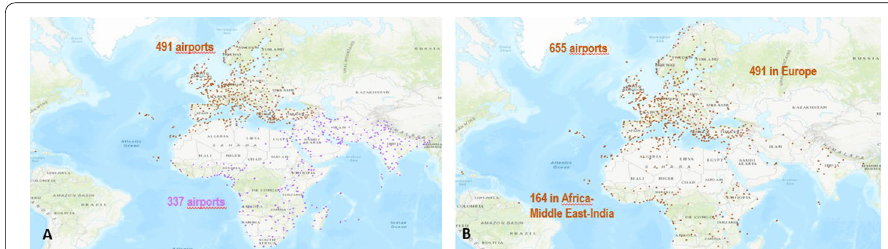
Fig. 3 Communities uncovered by Louvain are grouped in a single community by LPA. a Louvain reveals two communities in Europe (airports in brown) and Africa-Middle East-Southern Asia (airports in lavender). b LPA finds a unique community covering the same geographical area